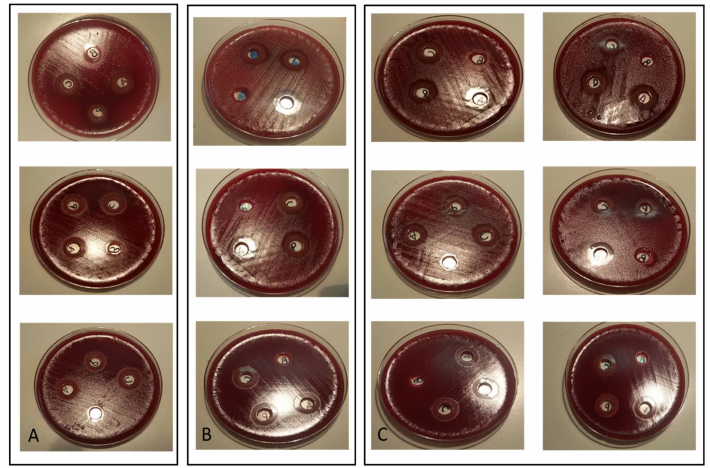
Figure 3. IZs from L. casei , L. paracasei , L. acidophilus (negative control, MRS broth). H. pylori susceptibility test was carried out vs. clarithromycin, metronidazole and levofloxacin. ( A ) H. pylori strains susceptible to all antibiotics. ( B ) H. pylori strains resistant to all antibiotics. ( C ) H. pylori strains resistant to one or two antibiotics. IZs are clearly visible.